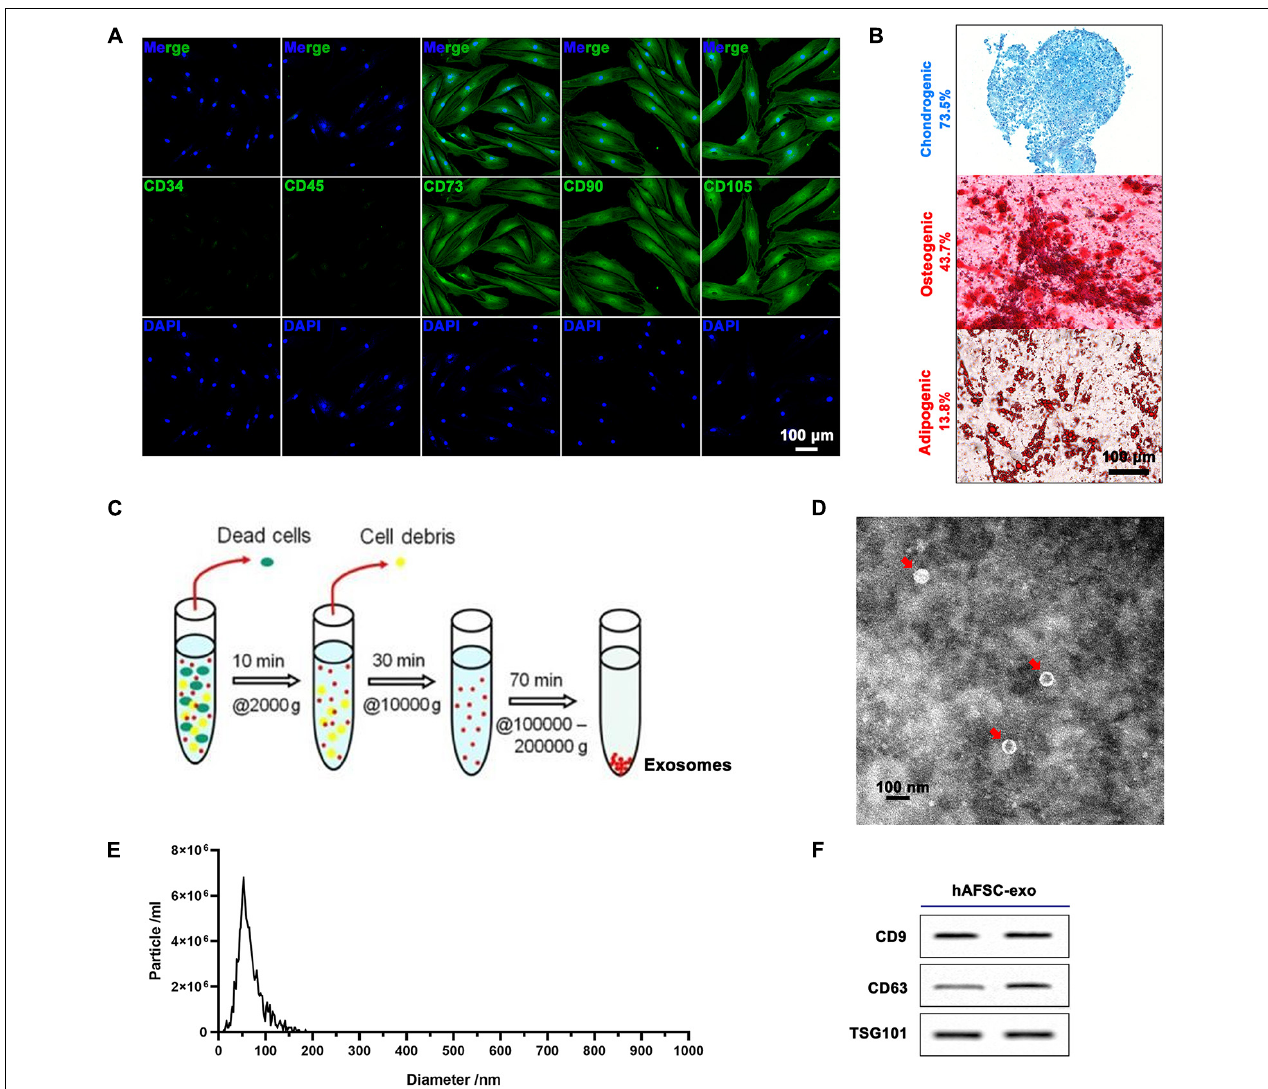
FIGURE 1 | Characterization of hAFSCs and hAFSC-exo. (A) IF staining of cell surface markers CD34, CD45, CD73, CD90, and CD105; scale bar = 100 µ m. (B) Osteogenic (Alizarin Red S staining), chondrogenic (Alcian Blue staining), or adipogenic (Oil Red O staining) differentiation induction of hAFSCs; scale bar = 100 µ m. (C) Schematic representation of exosome isolation. hAFSC-exo were isolated from hAFSC supernatant using high-speed centrifugation. (D) Morphological characteristics of hAFSC-exo were imaged using transmission electron microscopy (scale bar = 100 nm). (E) hAFSC-exo particle size was measured using NanoSight. (F) Protein expression of exosome markers of hAFSC-exo, including CD9, CD63, and TSG101, was detected using western blot analysis. hAFSC, human amniotic fluid stem cells; hAFSC-exo, human amniotic fluid stem cell-derived